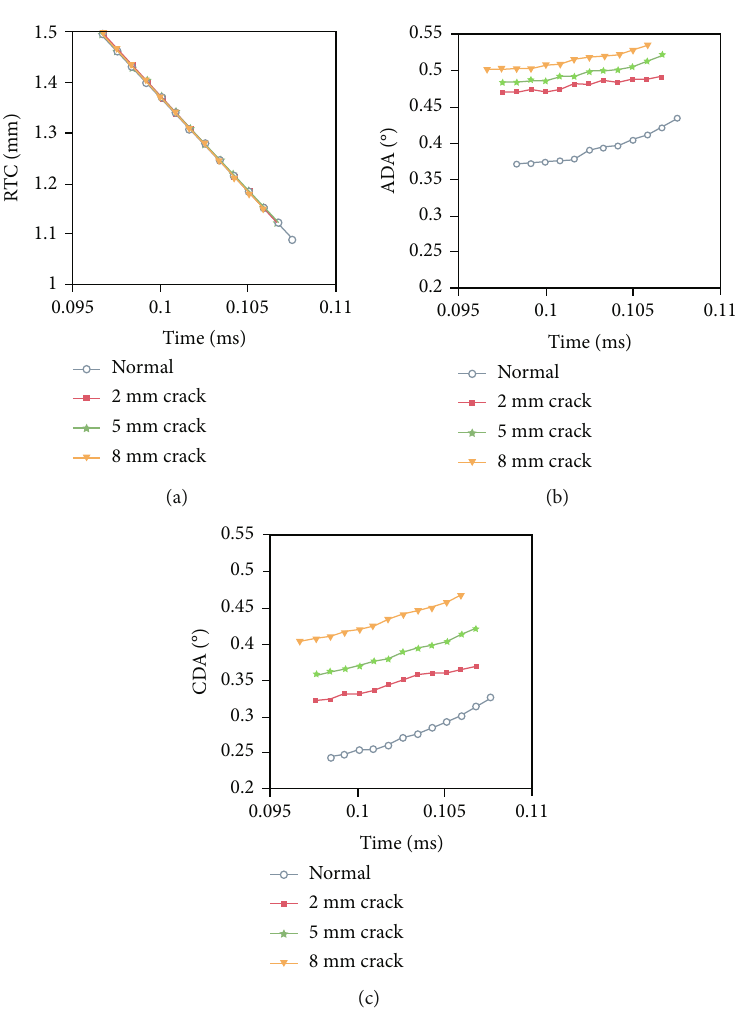
Figure 12: The 3D-BTC of blades with through-thickness crack of di ff erent depths. (a) RTC. (b)ADA. (c)